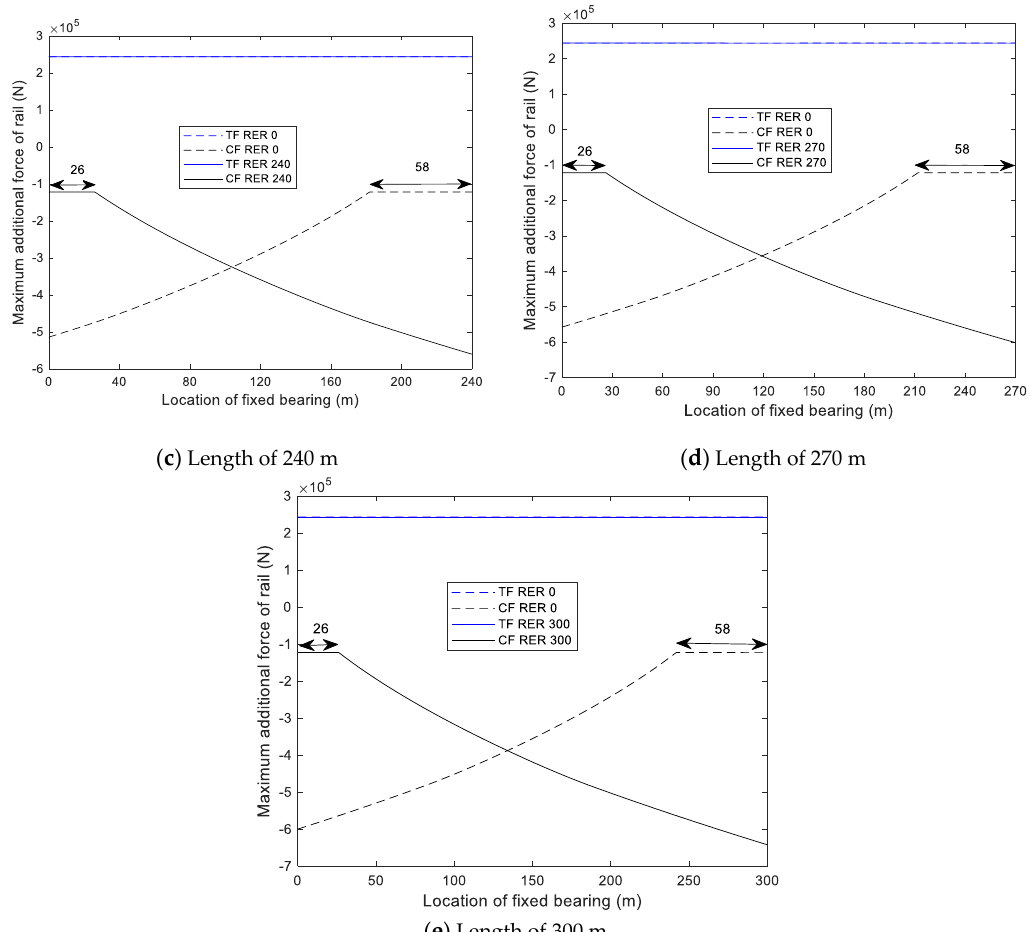
Figure 13. The curves of the maximum additional forces of rail changing with the location of the fixed bearing of continuous beams with five different lengths, in which RER is located above the left and right ends of the beam.